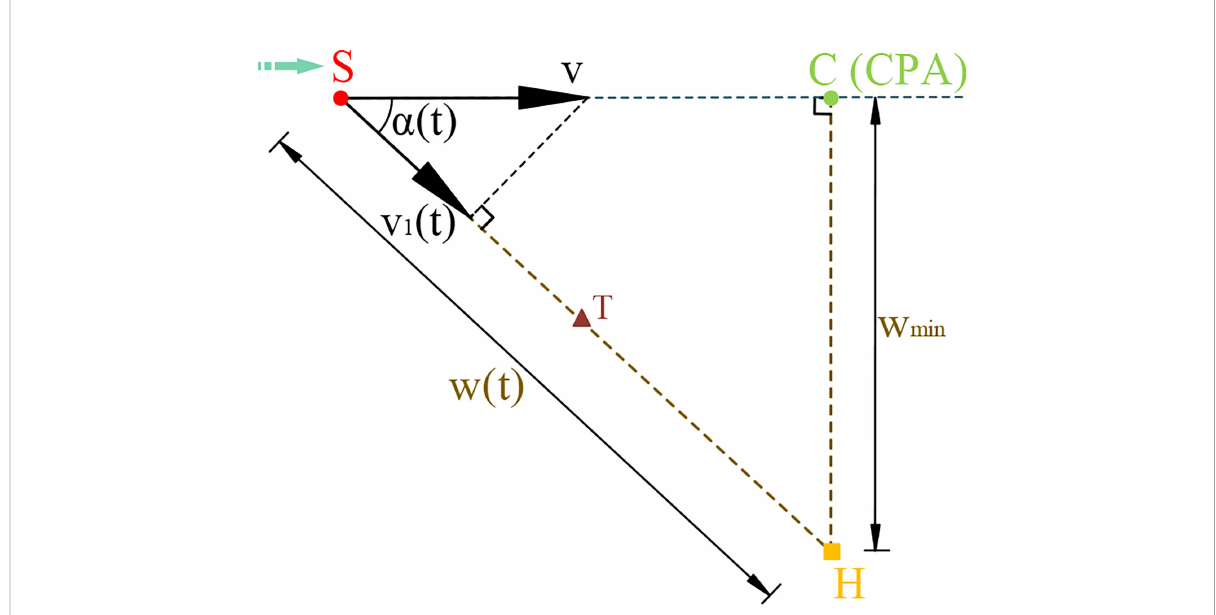
FIGURE 2 Top view of Figure 1. The slant range between the source and the hydrophone at time t is given by w . The distance from the hydrophone to the closest point of approach of the source is denoted by w min